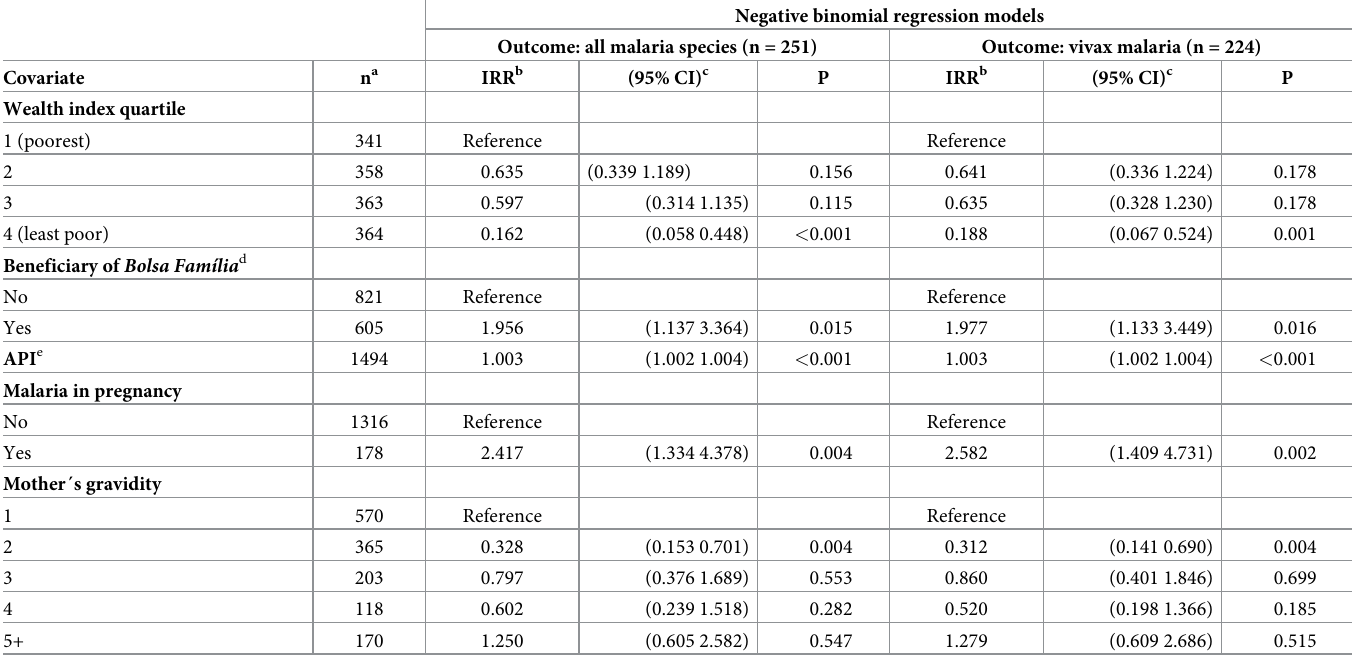
Table 1. Multiple negative binomial regression analysis of correlates of malaria (all species) and vivax malaria from birth to two years of age in children from the MINA-Brazil birth cohort study (n =